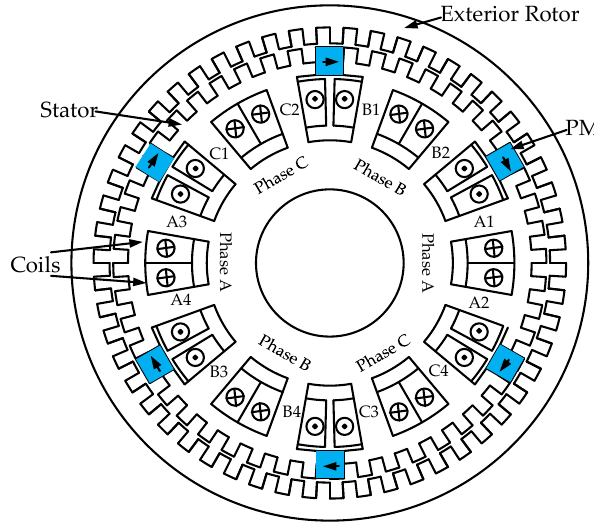
Figure 7. The new external rotor multi-teeth permanent magnet SRM [31].